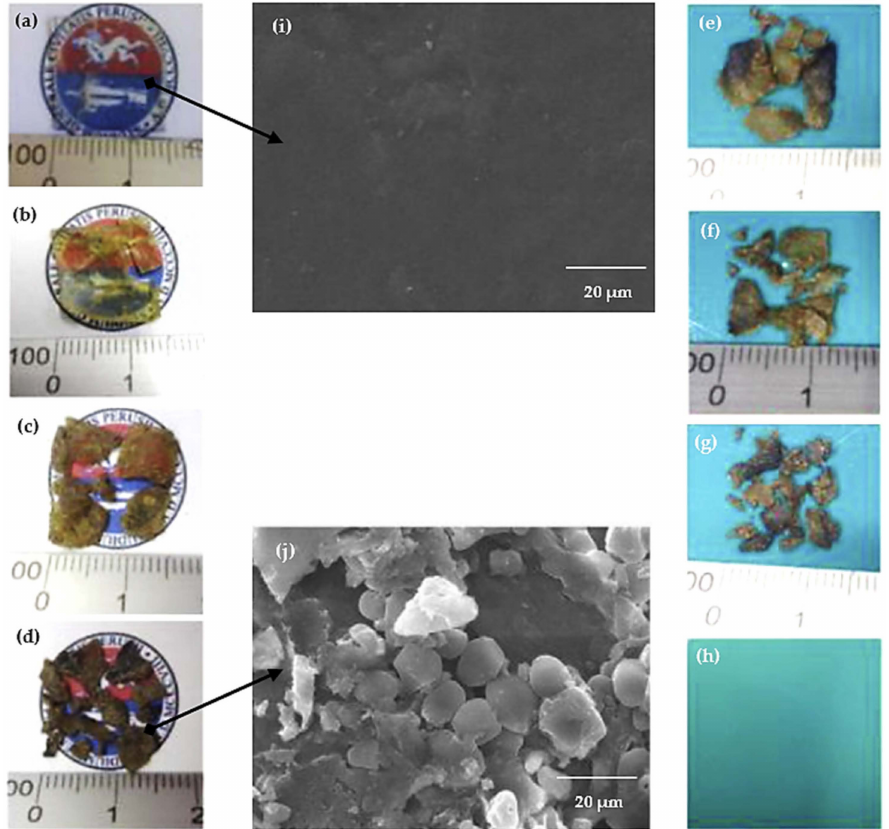
Figure 26. Disintegration process under composting conditions of TPS film at day ( a ) 0, ( b ) 1, ( c ) 11, ( d ) 18, ( e ) 25, ( f ) 32, ( g ) 39, and ( h ) 56. SEM micrograph of the disintegration process at day ( i ) 0 and ( j ) 18. Reproduced with permission from Polym. Degrad. Stab. , 159 , Sessini et al. Thermal and composting degradation of EVA/Thermoplastic starch blends and their nanocomposites, 184–198, 2019